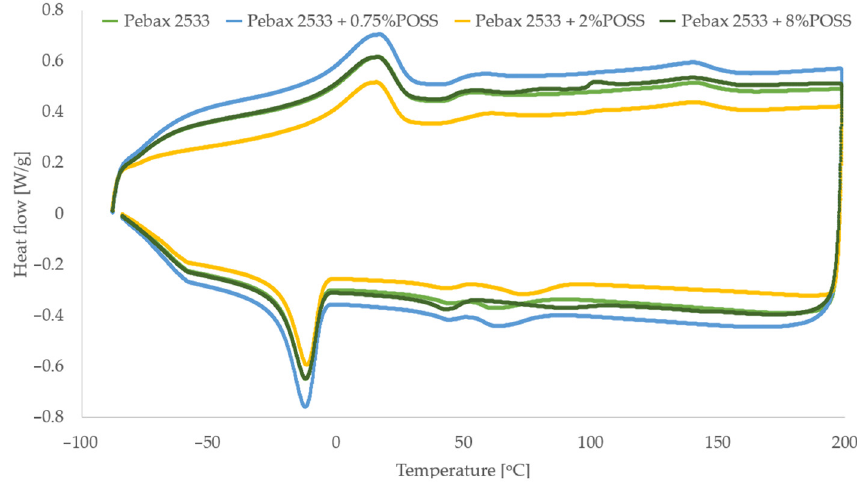
Figure A3. DSC thermogram for membranes containing POSS-Ph in different concentrations. Table A1. Temperatures at which the weight of the sample decreases by 5 wt% and 10 wt% for a membrane containing different concentrations of ZIF-8.